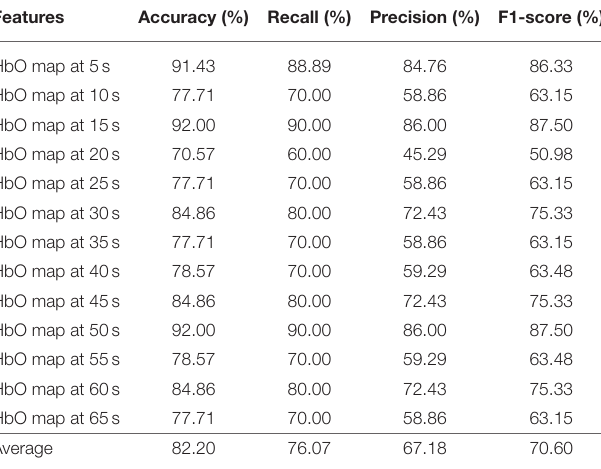
TABLE 6 | Convolutional neural network classification results of neuroimaging with spatial features for the VFT task.